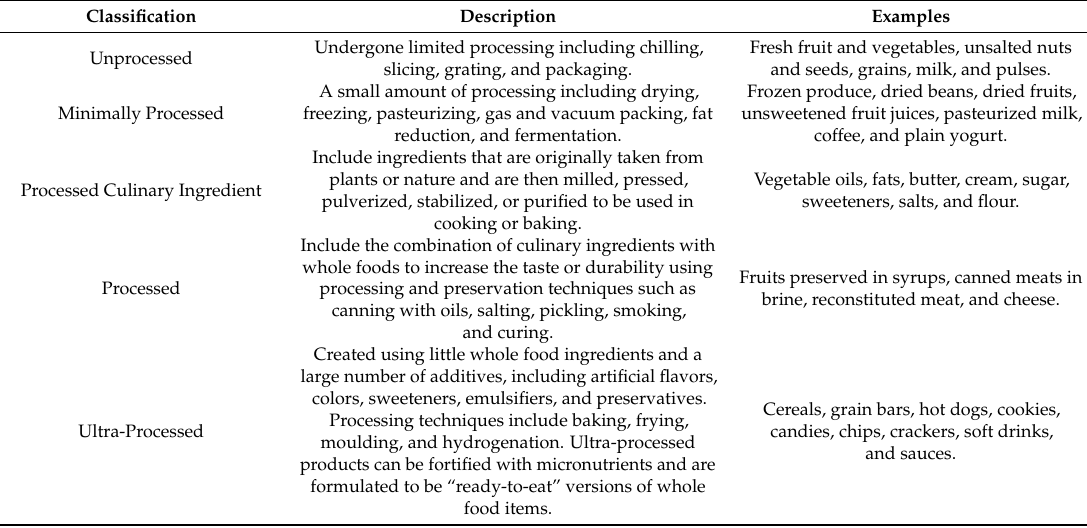
Table 1. Classification of the food processing levels adapted from Juul and Hemmingsson [13].